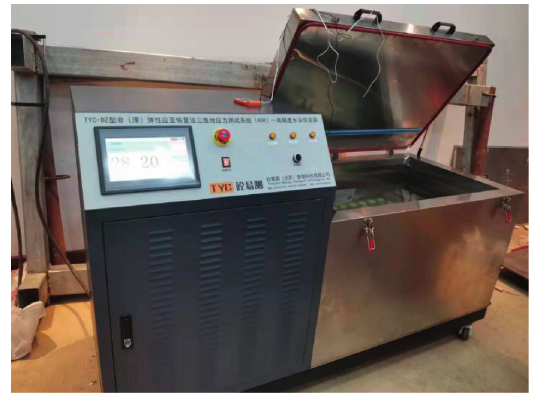
Figure 4: High-precision water bath constant temperature